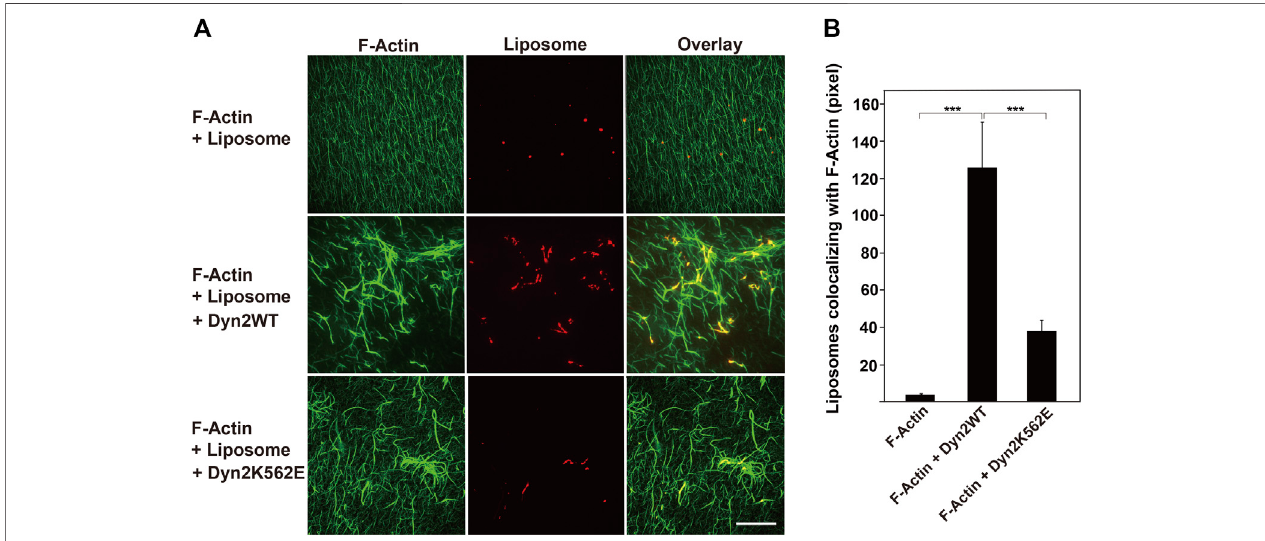
FIGURE 5 | Decreased interaction of actin bundles formed by dynamin 2-K562E with PIP 2 -containing lipid vesicles. (A) Actin fi laments (F-Actin) and lipid vesicles were visualized with Alexa Fluor 488-phalloidin (green) and Rhodamine-phosphatidylethanolamine (PE) (red), respectively. Preformed actin bundles by dynamin 2-WT (middle panels) or dynamin 2-K562E (bottom panels) were mixed with rhodamine-labeled lipid vesicles. Note that thick actin bundles formed by dynamin 2-WT associated with several lipid membranes. In the presence of dynamin 2-K562E, actin bundles were thinner and bound to few lipid vesicles. Scale bar: 20 μ m. (B) Quanti fi cation of liposomes colocalizing with actin fi laments. Data are means ± S.E.M. of 10 images (F-Actin), 25 images (F-Actin + Dyn2 WT) or 25 images (F-Actin + Dyn2 K562E) from three independent experiments. (*** p < 0.001).